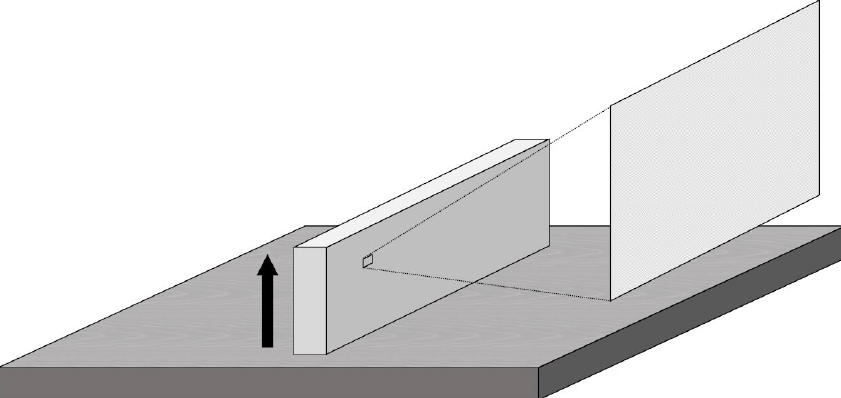
Figure 1. The printing direction (black arrow) and evaluated region for Vickers hardness number (VHN) and three-dimensional (3D) microlayer structure.